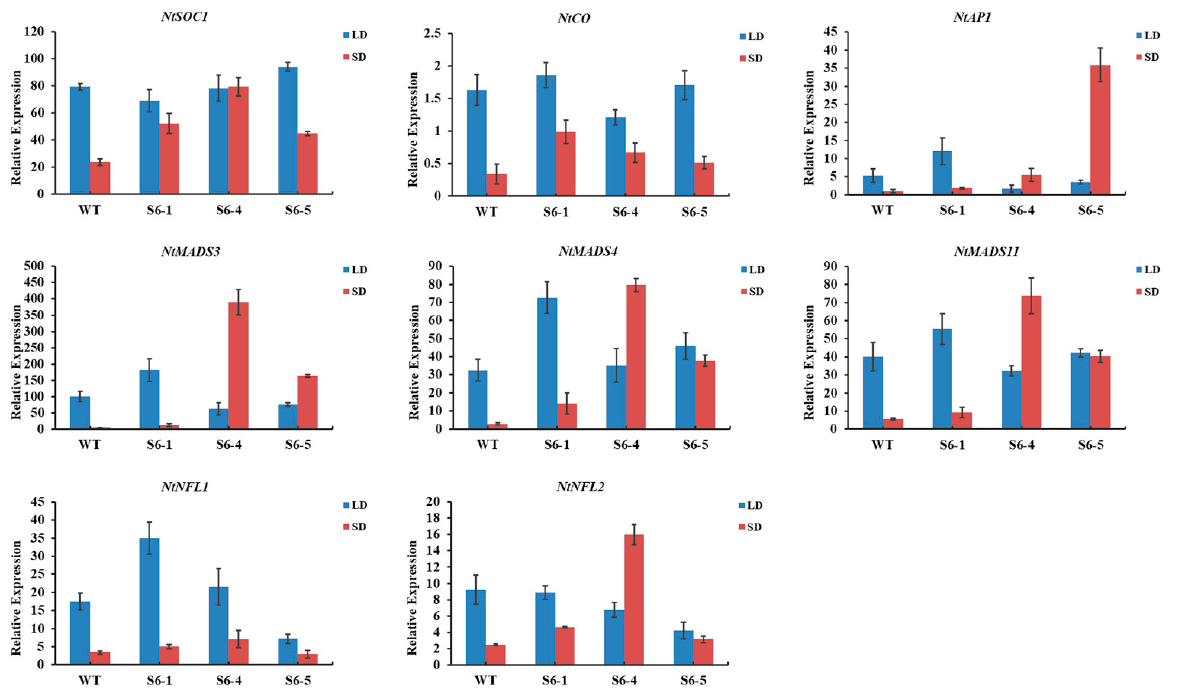
Figure 8. The relative expression of endogenous flowering-related genes in PmSBP6 transgenic tobacco under long and short conditions. S6-1, S6-4, and S6-5 were three transgenic lines.